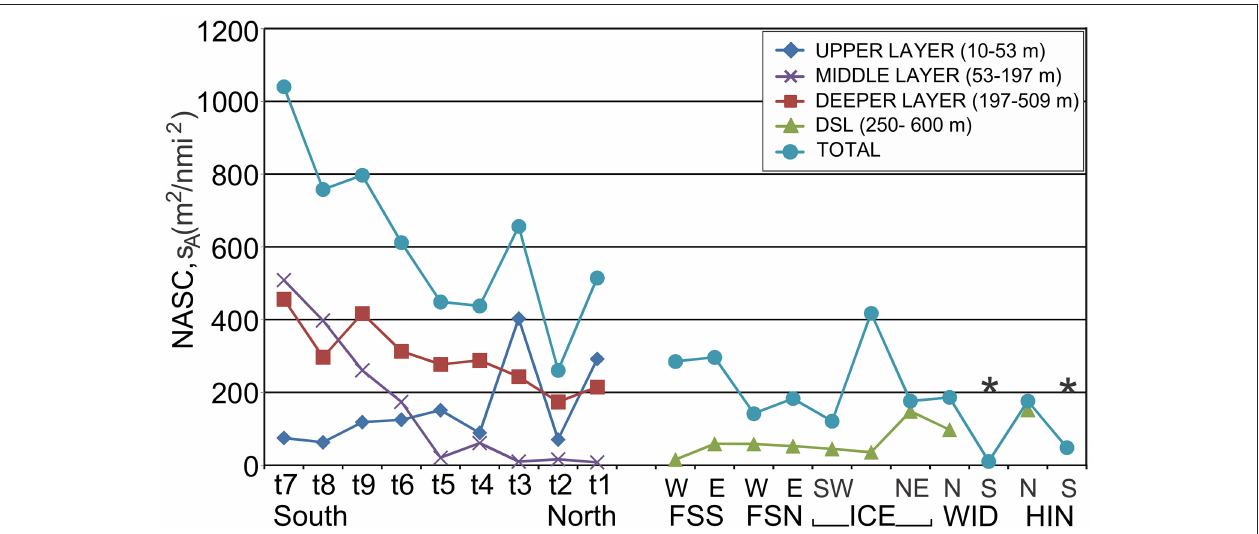
FIGURE 9 | Left: Integrated Nautical area scattering coefficient (s A ) in units of (m 2 nmi − 2 ) in layers 10–53, 53–197, and 197–509m, averaged over individual transects t1–t9 in the eastern Norwegian Sea where bottom depth exceeded 509m from ∼ 62 to 68 ◦ 33 (1993) . Right: Integrated s A for subsections of Fram Strait South (FSS), Fram Strait North (FSN), Along Ice Edge (ICE), Wijdefjorden (WID), and Hinlopen (HIN). W, E, N, S, SW, NE represent West, East, North, South, South-West and North-East, respectively. The central subsection along ice edge not explicitly marked. *Water column too shallow for DSL